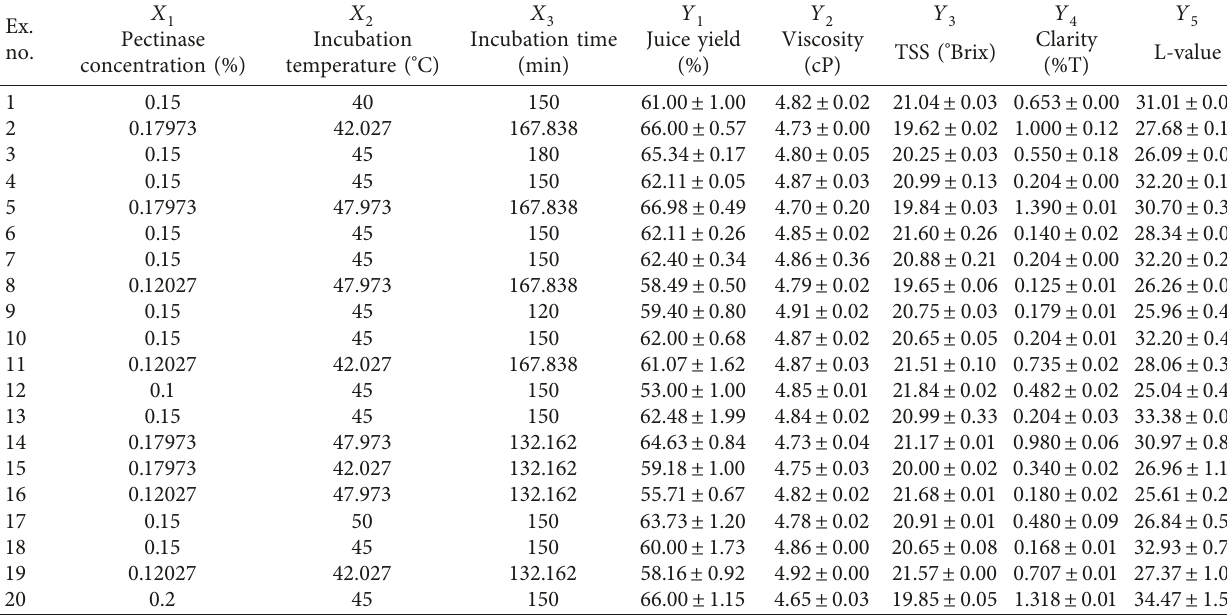
Experimental values of responses are indicated as mean ±